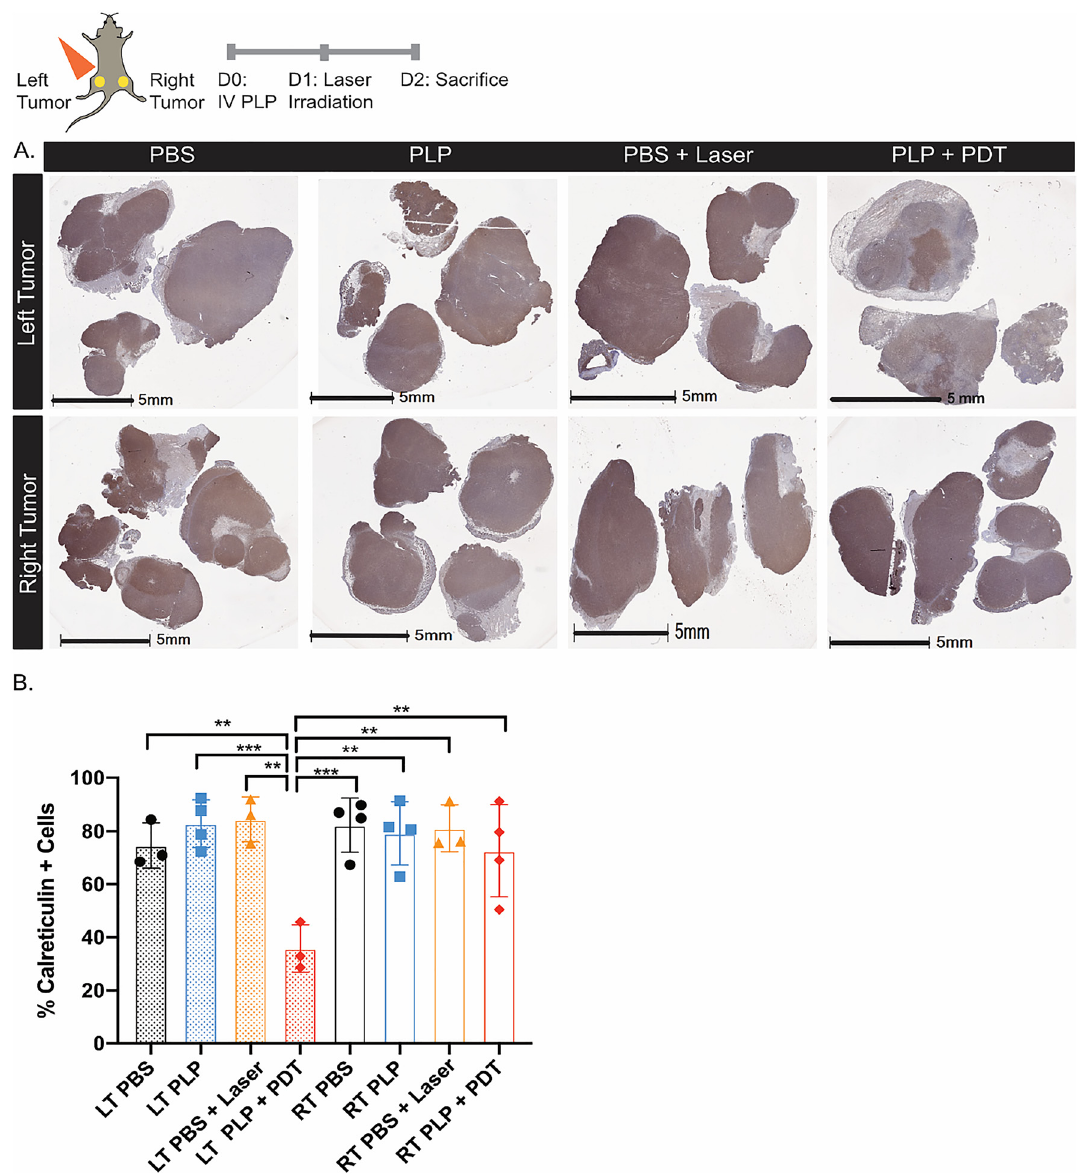
Figure 3: PDT reduced calreticulin expression in irradiated tumors. Dual AE17-OVA + tumor bearing mice were treated once with either